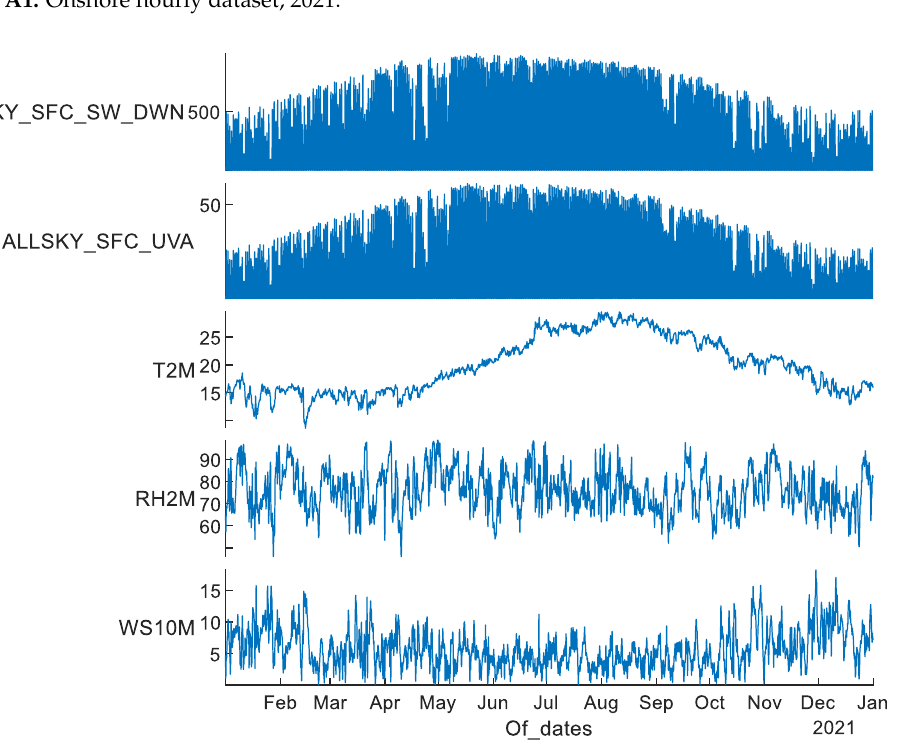
Figure A1. Onshore hourly dataset, 2021.